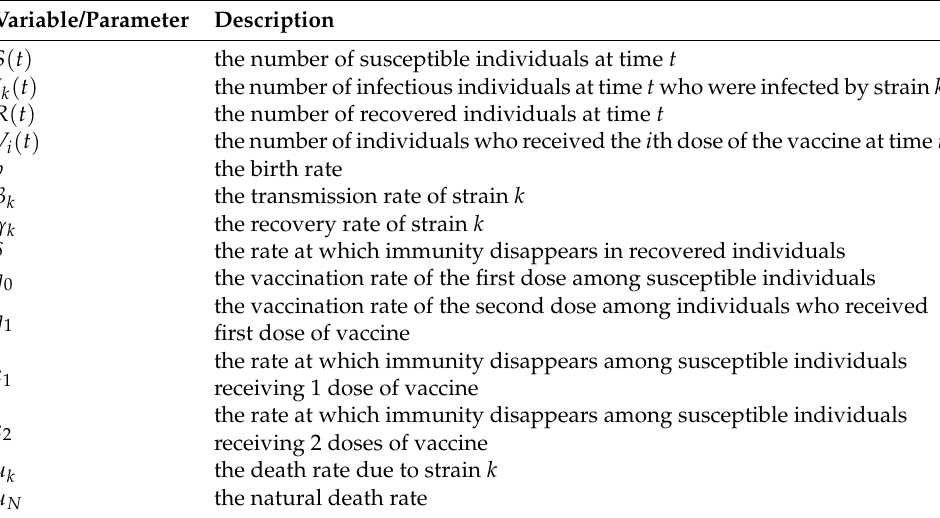
Table 1. Description of variables and parameters in model (1).